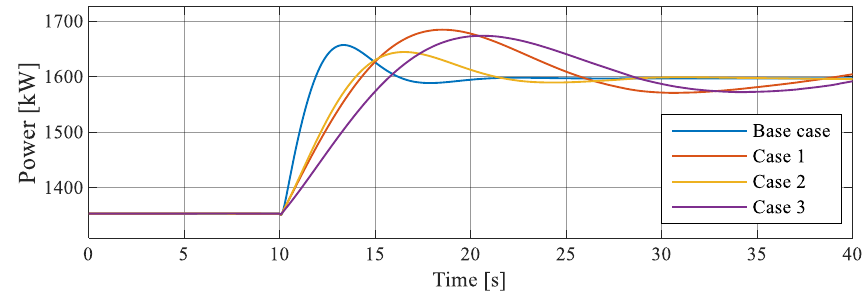
Figure 15. Power generated by the thermal power plant.